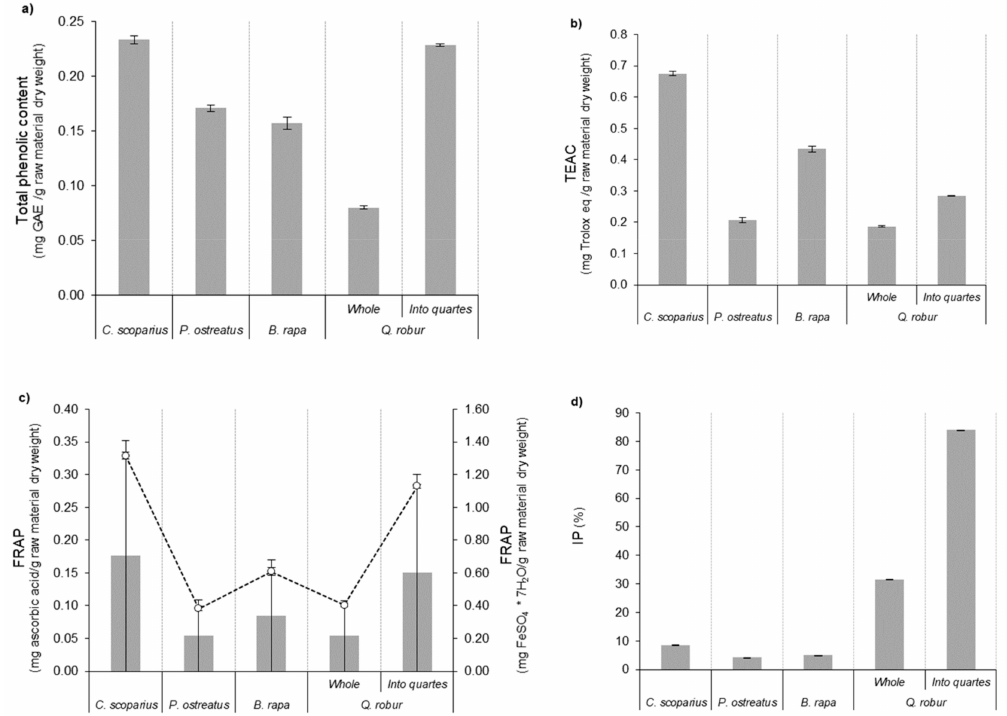
Figure 2. Total phenolic content ( a ) and antioxidant capacity, expressed as TEAC value ( b ), FRAP assay ( c ) as ascorbic acid equivalents (circles) and as ferric sulphate equivalents (bars) and inhibition percentage (IP) of DPPH radical ( d ), from the aqueous collected of the di ff erent took in consideration raw materials at 100 W by MHG